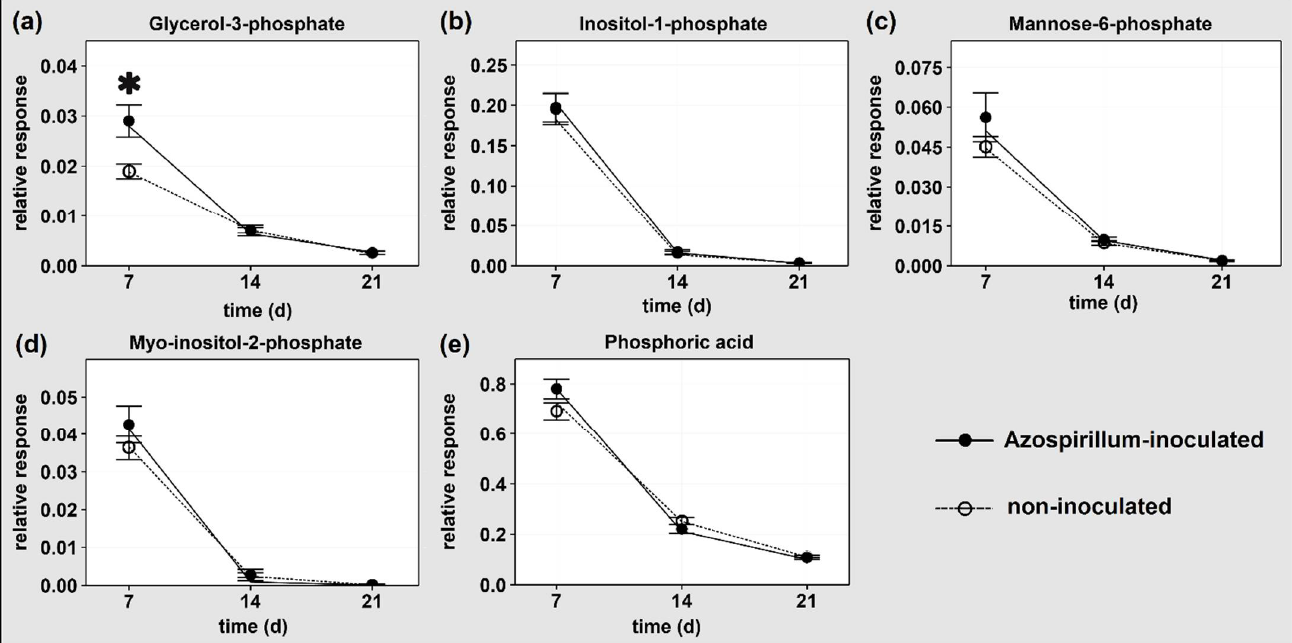
Figure 1. Relative response of P-containing compounds in roots of plants with or without Azospirillum inoculation and harvested after 7, 14, and 21 DAI. Means ± standard error are presented. n = 6 for all samples except for non-inoculated at 21 DAI ( n = 8). Asterisks in the graphs indicate a fold change (FC) <−1.5 or >1.5 and probability of significant difference between relative response of Azospirillum-inoculated and non-inoculated plants based on Student’s t -test p < 0.05 (see also Table S1).